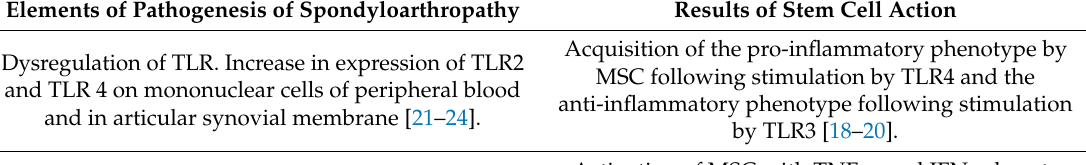
Table 1. An analysis of a potential role of stem cells in the development of spondyloarthropathy. Elements of Pathogenesis of Spondyloarthropathy Results of Stem Cell